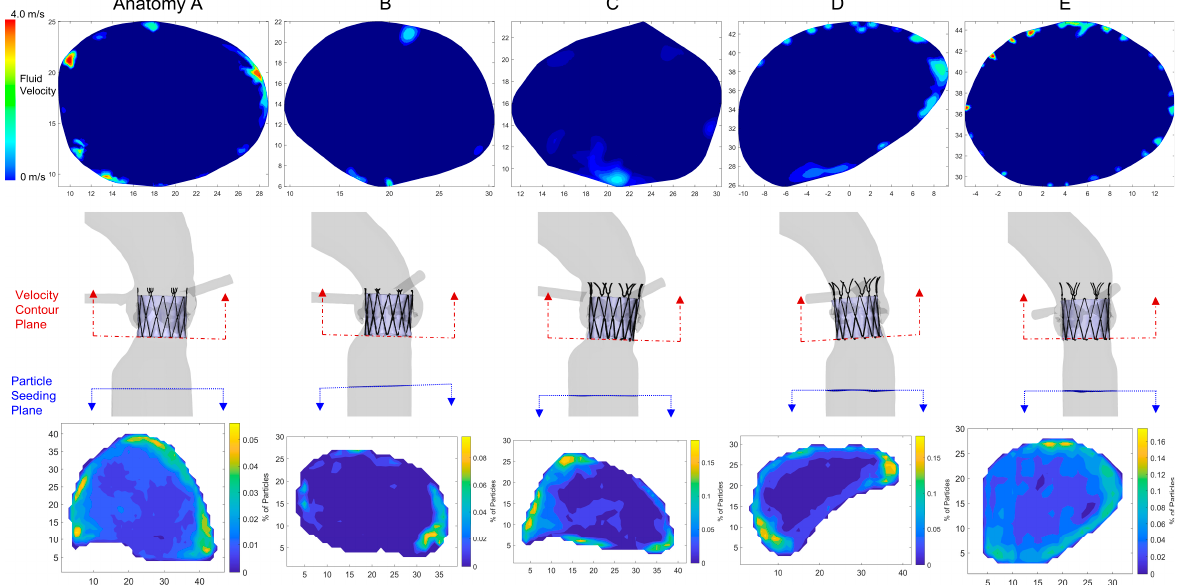
Figure 6. Contour plots of LVOT velocity and concentration of platelets entering the PVL domain— Top are velocity contour plots in the LVOT perpendicular to the bottom of the TAVR stent. Bottom contours represent the concentration of the starting position of the PVL platelets in the LVOT, showing concentrations towards the lumen surface. Each column represents the patient-specific anatomies ( A – E